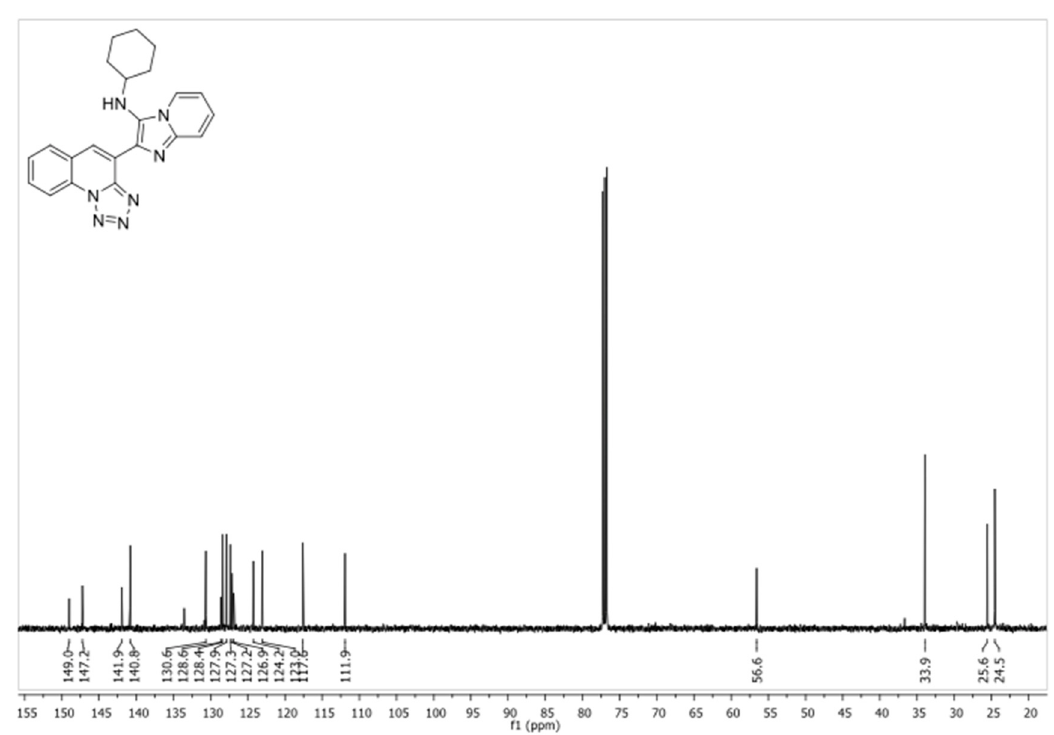
Figure 2. 13 C NMR spectrum of compound 5a